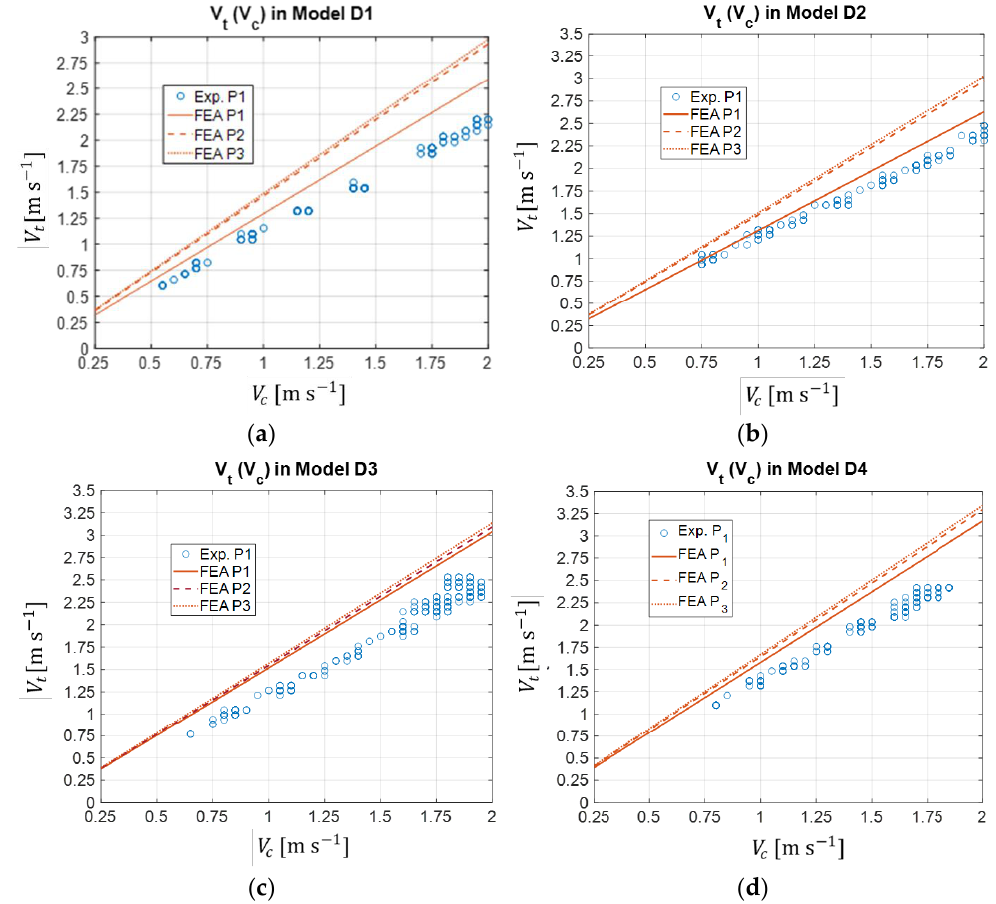
Figure 16. Characteristic 𝑉 𝑡 (𝑉 𝑐 ) in points P1, P2, and P3 for duct models D1 ( a ), D2 ( b ), D3 ( c ), and D4 ( d ).